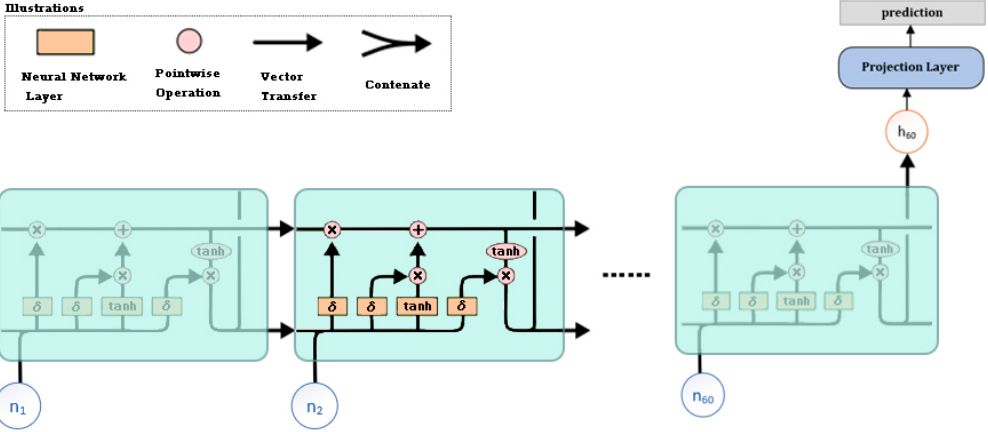
Figure 2. Illustration of LSTM model